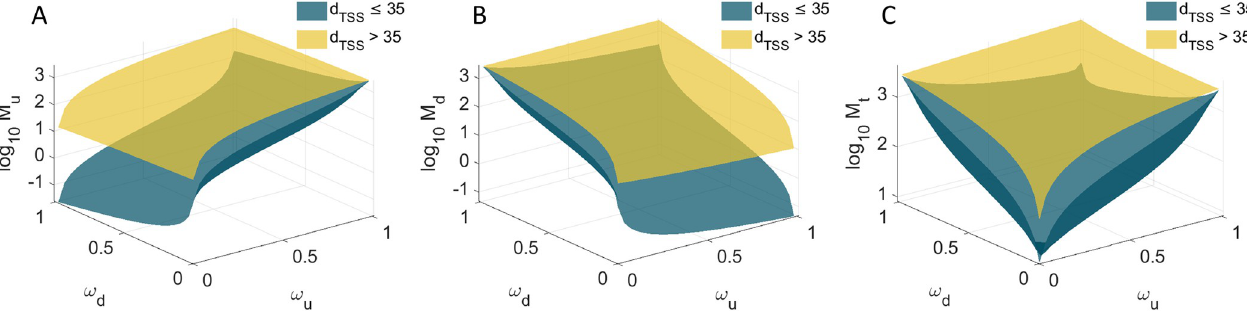
Fig 9. Mean protein expression as a function of both promoters’ occupancy. Expected mean protein numbers due to the activity of: ( A ) the upstream promoter alone, ( B ) the downstream promoter alone, and ( C ) both promoters. M 1) and the downstream (0 � ω d � 1) promoters are occupied by RNAP, when d TSS > 35 (yellow) and d TSS � 35 (dark green)